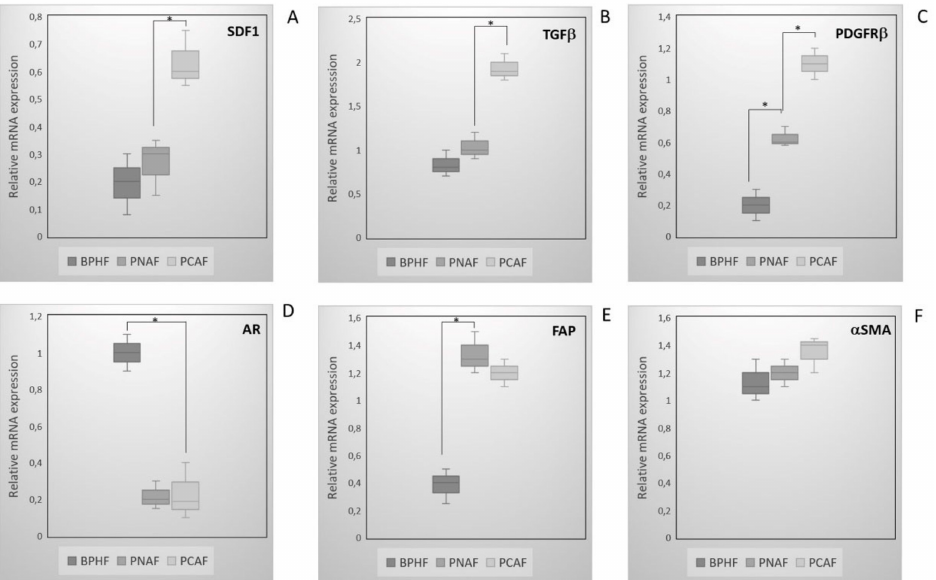
Figure 4. Expression of CAF-related genes in an independent set of PCAF, PNAF, and BHPF samples. Expression levels of SDF1 ( A ), TGF β ( B ), PDGFR β ( C ), AR ( D ), FAP ( E ), and α SMA ( F ) were detected in 17 PCAFs compared to 12 PNAFs and 12 BPHFs by qRT-PCR analysis. The values shown are the 2 − ∆∆ Ct ratios of the difference between cycle thresholds ( ∆ Ct) of the corresponding marker genes and the housekeeping gene TBP; n = 3 independent differentiation experiments * p ≤ 0.001.